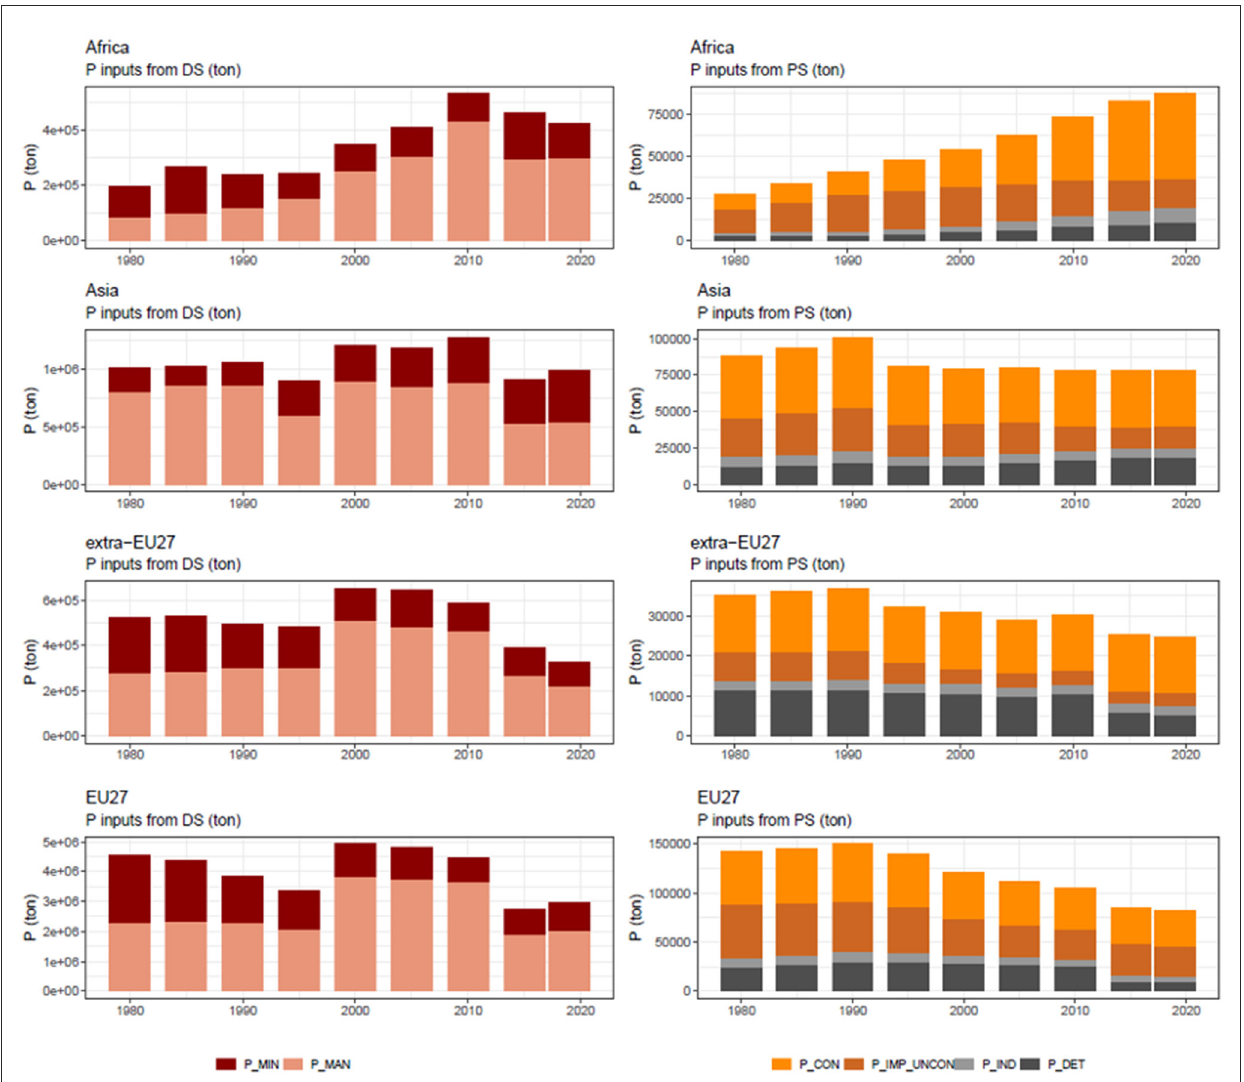
FIGURE8 Phosphorus inputs (ton) by selected continents in the study area. On the left , diffuse sources: P_MIN P mineral fertilizer and P_MAN P manure; on the right , point sources: P_CON P emissions collected in sewerage systems; P_IMP_UNCON P emissions from other systems that are disconnected from sewerage systems; P_IND P contribution from industrial discharges; and P_DET P emissions from